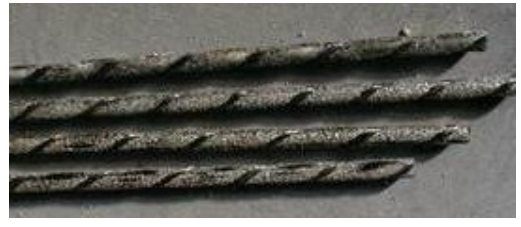
Figure 3. Carbon fibre-reinforced polymer (CFRP) bars: bars are sandblasted and superficially deformed.